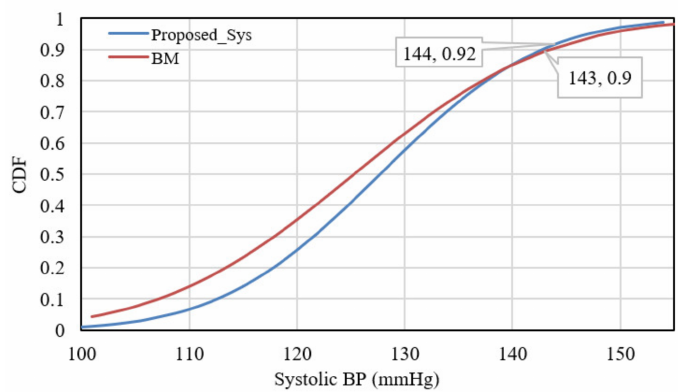
Figure 13. The CDF plot for systolic BP